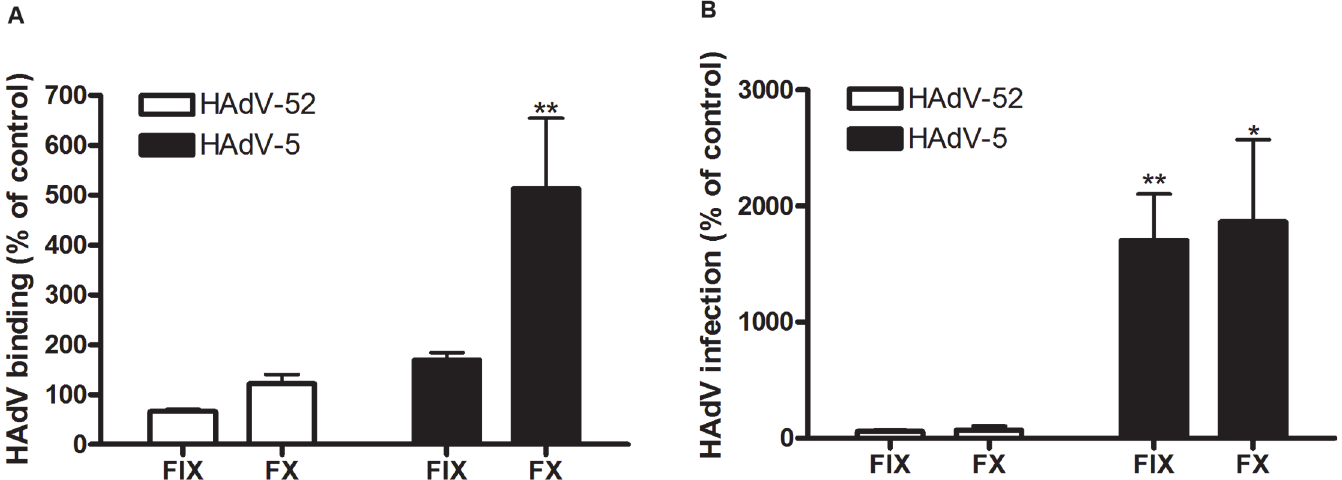
Fig 2. HAdV-52 does not use coagulation factors for binding and infection of A549 cells. (A) 35 S-labeled HAdV-52 virion binding to A549 cells after virion preincubation with physiological concentrations of coagulation factor IX and X (FIX: 5 μ g/ml and FX: 10 μ g/ml). (B) HAdV-52 infection of A549 cells after virion preincubation with physiological concentrations of coagulation factors. All experiments were performed three times with duplicate samples in each experiment. Error bars represent mean ± SD. * P of < 0.05 and ** P of < 0.01 versus